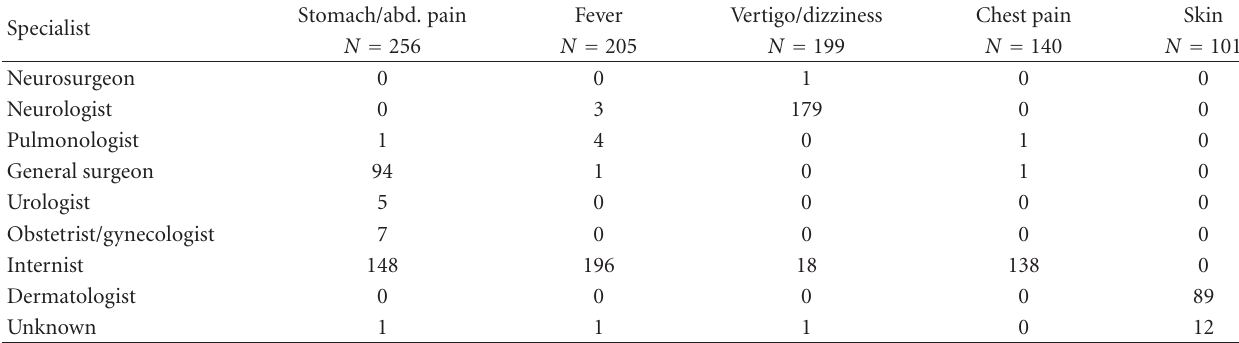
Table 3: Frequencies of specialist referral for the five most common